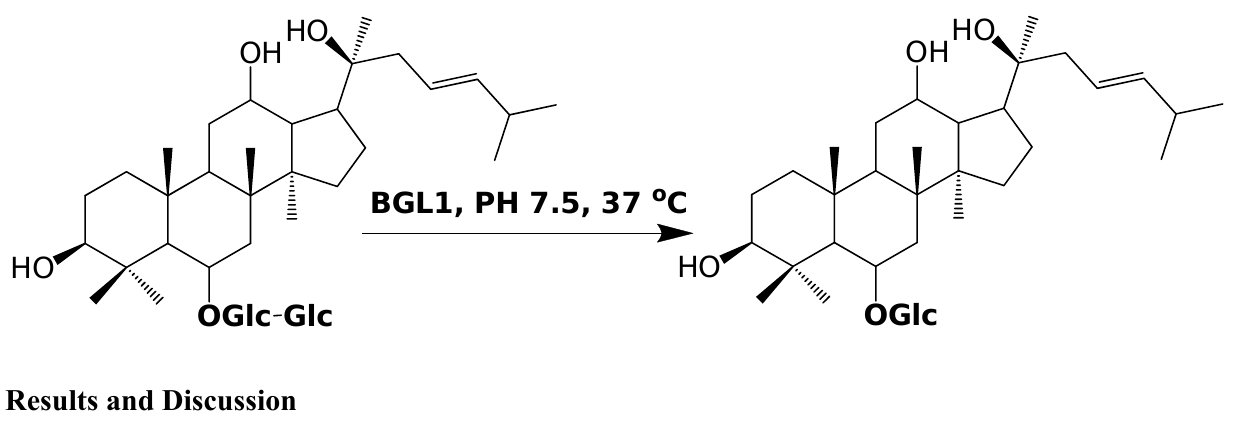
catalyzed by BGL1. 1 HO OH